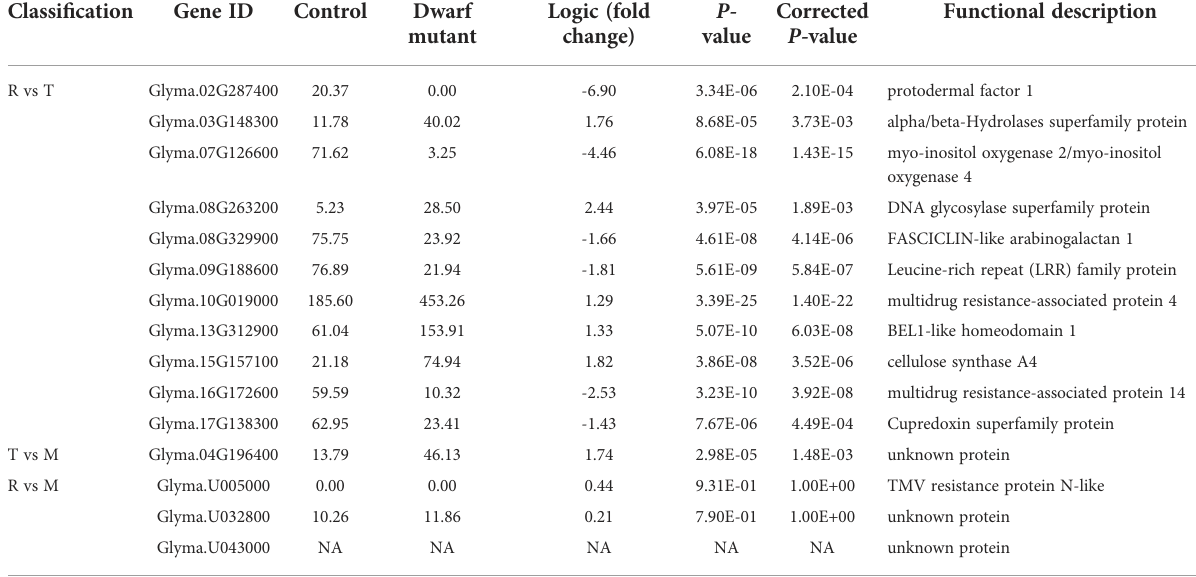
TABLE 2 Expression level of common genes identi fi ed from resequencing, transcriptome and methylome datasets. Classi fi cation Gene ID